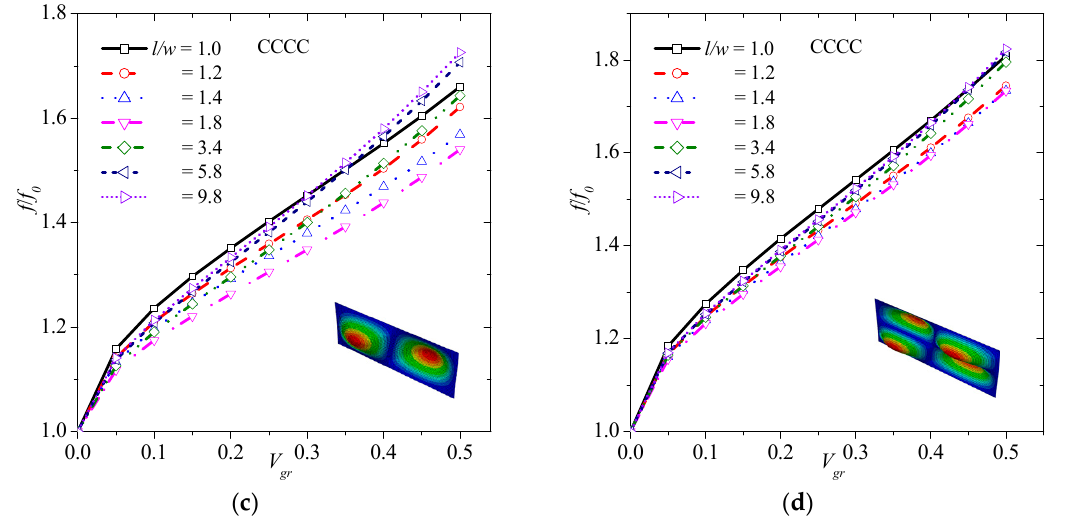
Figure 4. Normalized frequency versus volume fraction of graphene considering ( a ) (1,1), ( b ) (1,2), ( c ) (2,1), and ( d ) (2,2) vibration mode for the CCCC boundary condition.